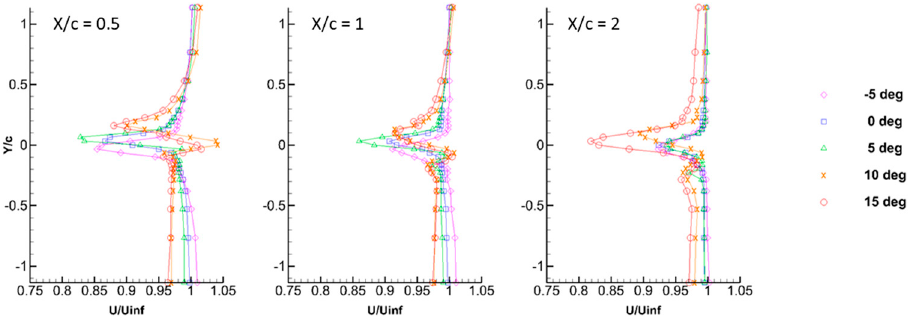
Figure 11. Line plots of time-averaged axial velocity at the vortex core.